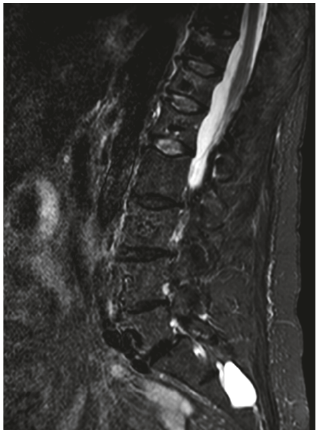
Figure 3: Postoperative sagittal magnetic resonance image of the spine 3 months after surgery, showing increased signal and signs of slight recollapsing, especially in the thoracolumbar transition on the STIR